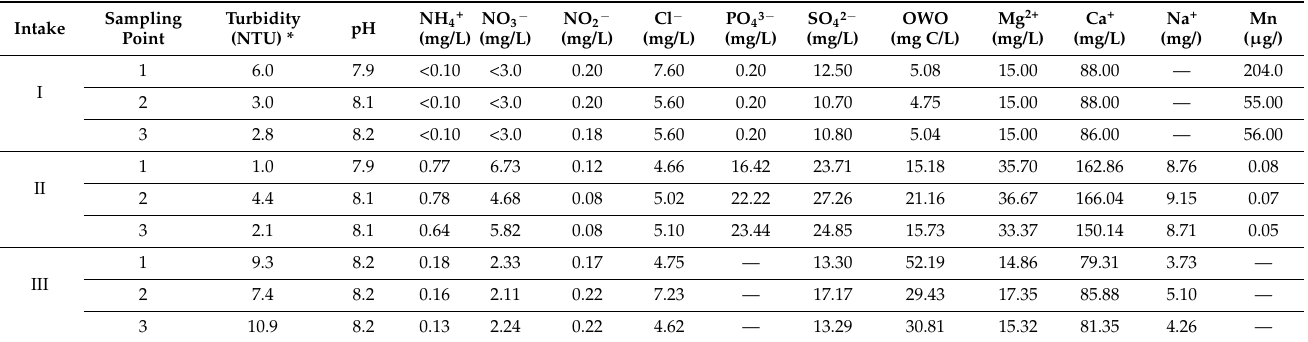
Table 2. Average values of selected physicochemical parameters of the Gołdapa river from